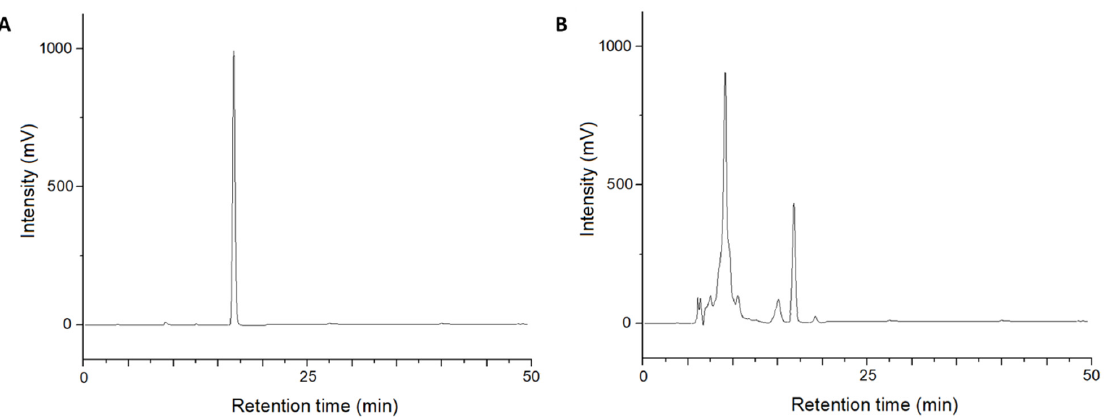
Figure 2. ( A ) Chromatogram of EPYR standard analyzed at 250 µ g/mL; ( B ) chromatogram of the organic extract obtained at regular pH of isolate 9 (SNM 5A2), analyzed at 2 mg/mL.